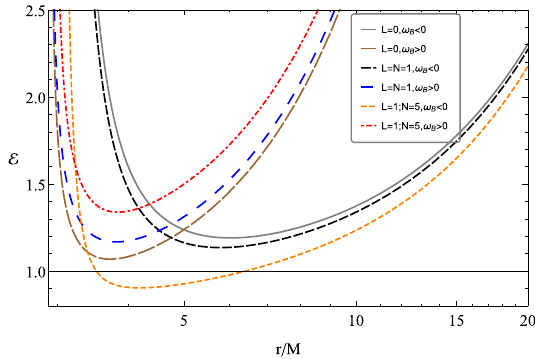
Fig. 7 Radial dependence of specific energy of the charged particle with magnetic interaction parameter | ω B | = 0 . 1 at circular orbits